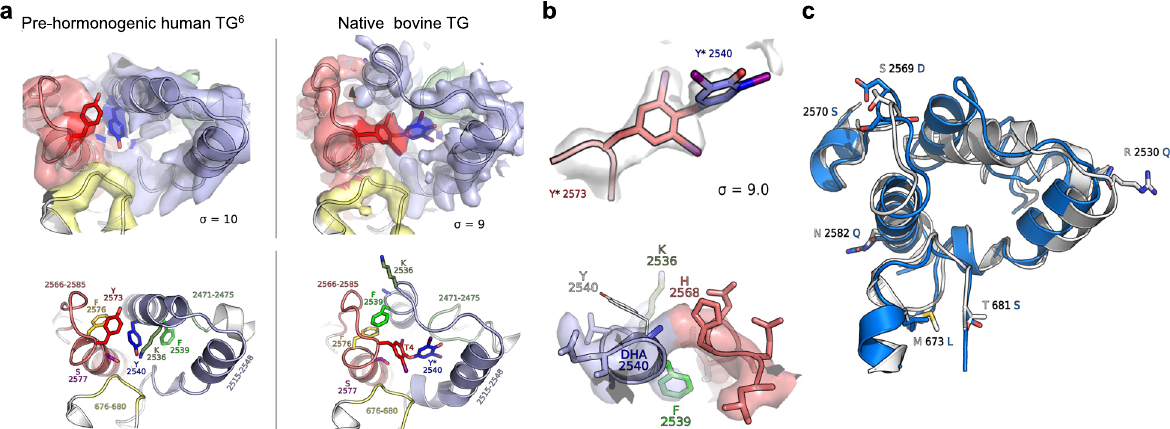
Fig. 4 Nascent thyroid hormone at hormonogenic site B. a Left and right panels, respectively, show the pre-hormonogenic conformation of human TG (from Ref. 6 ) and the present analysis of native bovine TG. Top: Density maps of hormonogenic site B. Red, acceptor tyrosine Y2573; blue, donor tyrosine Y2540; green, F2539; gold, F2576; corresponding pale colors mark structural elements including the respective residues. Sigma, map contour level. Bottom: Atomic models derived from density maps in the top panel with the same color coding. The nascent thyroid hormone in the right panel is modeled as T 4 . Y*2540, transferred donor iodophenolic ring. Asterisk, residual donor site. b Top: Density map for the acceptor site superimposed on a model of T 4 thyroid hormone (i.e., both aromatic rings modeled as 3,5-di-iodinated). Bottom: density map and model for the donor site showing fi ts to map of both the residual dehydroalanine (DHA 24540) and an unmodi fi ed Y2540. Maps of bovine TG in this fi gure were generated by density modi fi cation of cryoSPARC half-maps using the ResolveCryoEM tool from Phenix. c Overlay of hormonogenic site B regions of pre-hormonogenic human TG (white) and native bovine TG with nascent hormone (blue) illustrating the structural reorganization accompanying hormone formation. Positions of the non-conserved amino acid residues, all in peripheral locations, are marked.